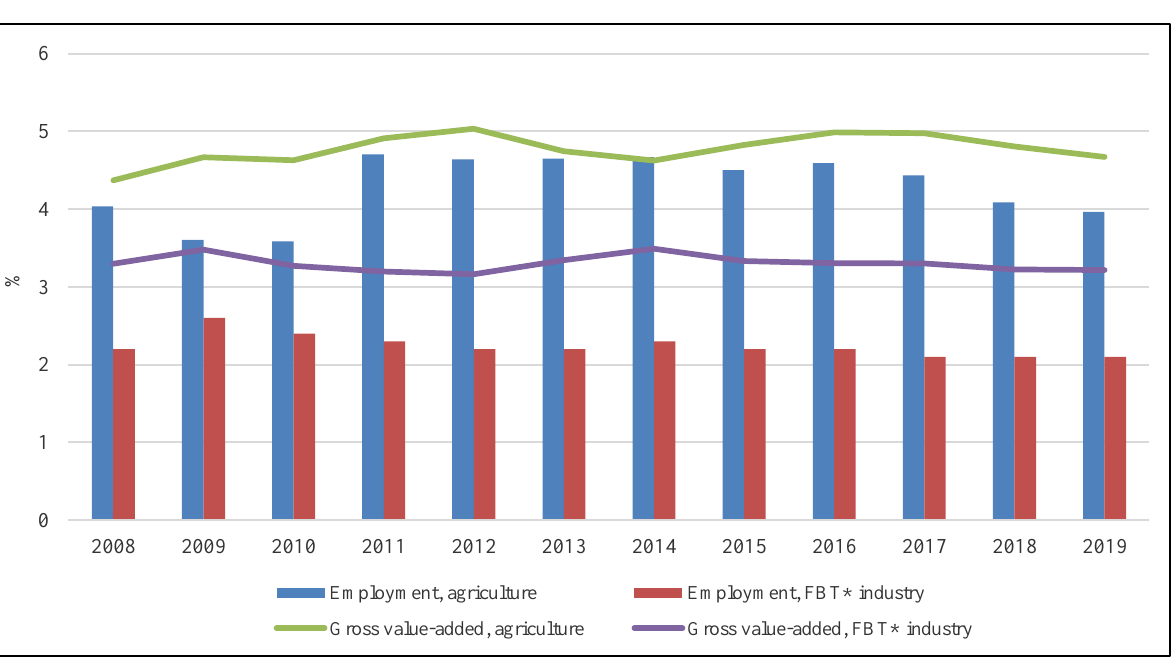
Figure 2. Employment and gross value-added of the agri-food sector; Source: Author’s composition based on HNSO [21, 22] Agriculture plays a more important role in the agribusiness than the food, beverages, and tobacco industry